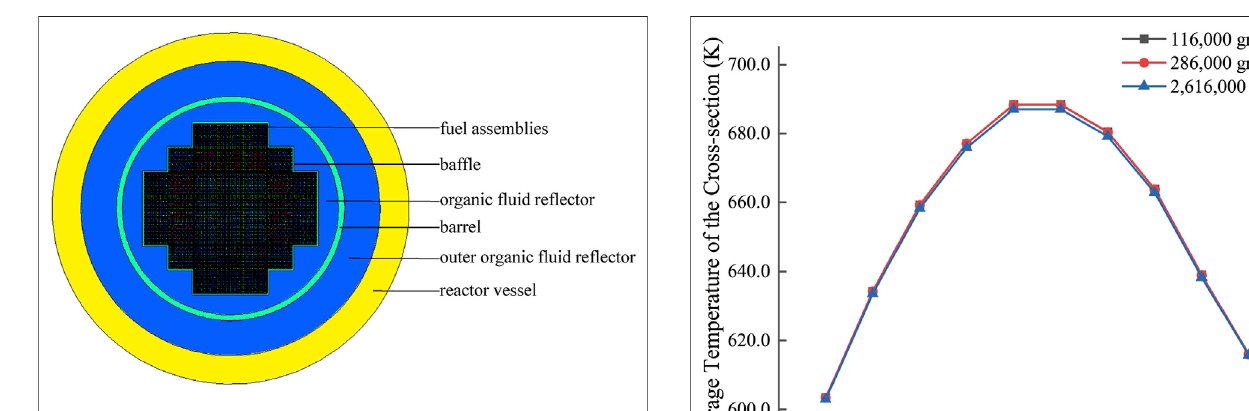
FIGURE 3 | Cross-sectional view of the physical model.